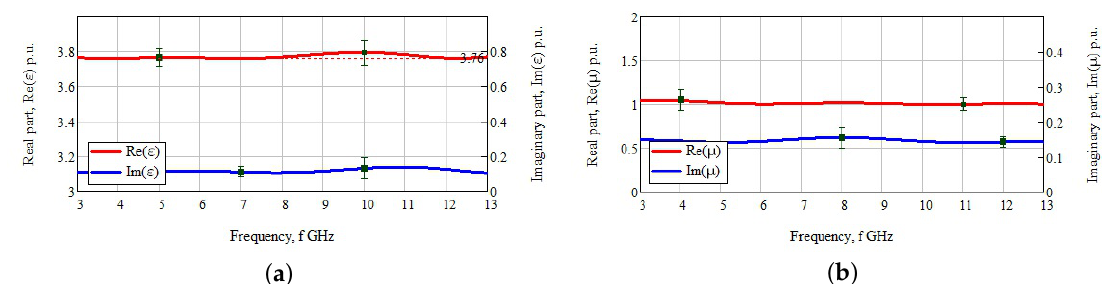
Figure 11. Measured values of relative dielectric permittivity ( a ) and magnetic permeability ( b ) for